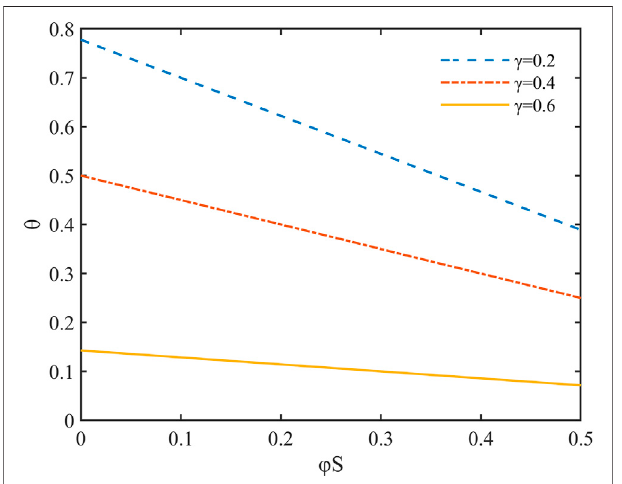
FIGURE 6 | The impact of P on x ( t )